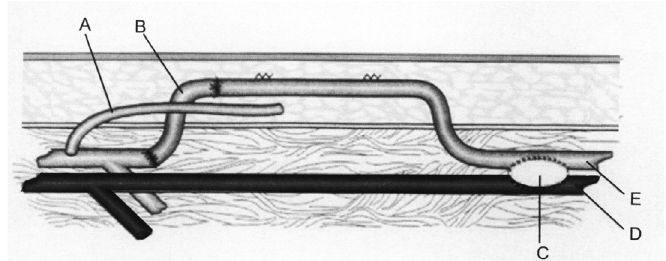
FIGURE 3 - Superficial femoral vein extension. A. Greater saphenous vein. B. PTFE 8 mm interposition graft. C. Femoral artery – SFV anastomosis. D. Popliteal artery. E. Patent popliteal